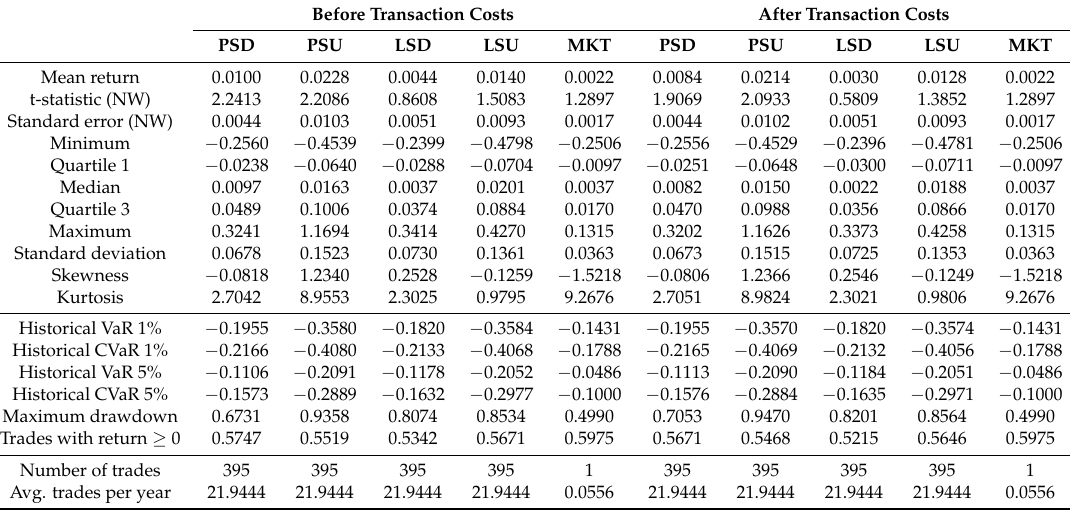
Table 3. Return characteristics, risk metrics, and trading statistics per trade for PCA straddle delta hedged (PSD), PCA straddle delta unhedged (PSU), largest constituents straddle delta hedged (LSD), and largest constituents straddle delta unhedged (LSU) from January 2000 until December 2017. NW denotes Newey–West standard errors and CVaR the conditional value at risk.